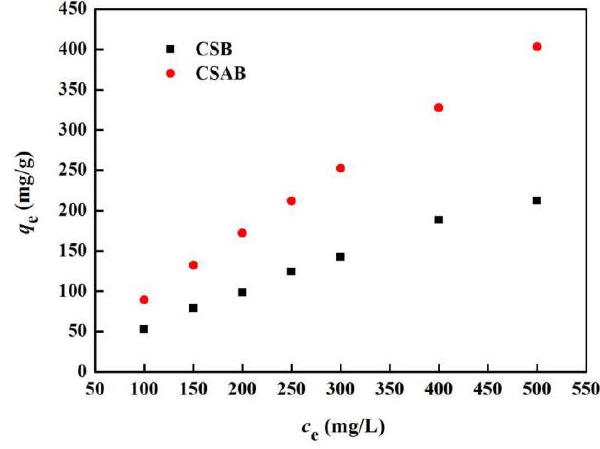
Figure 11. Adsorption isotherms of diesel oil onto crab shell biochars. Table 3. The thermodynamic parameters in the equation of biochar on diesel crab. Sample